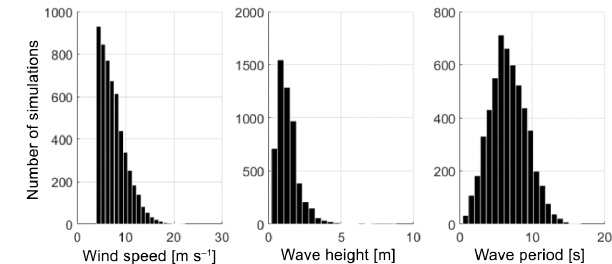
Figure 6. Histograms indicating marginal distributions of sampled environmental